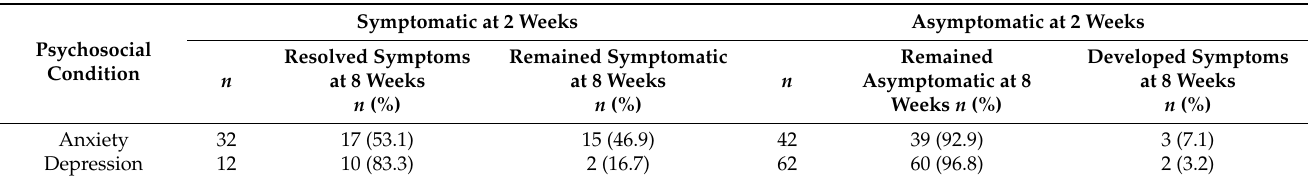
Table 3. Dynamics of anxiety and depressive symptoms among family members at 2 and 8 weeks after discharge ( n =